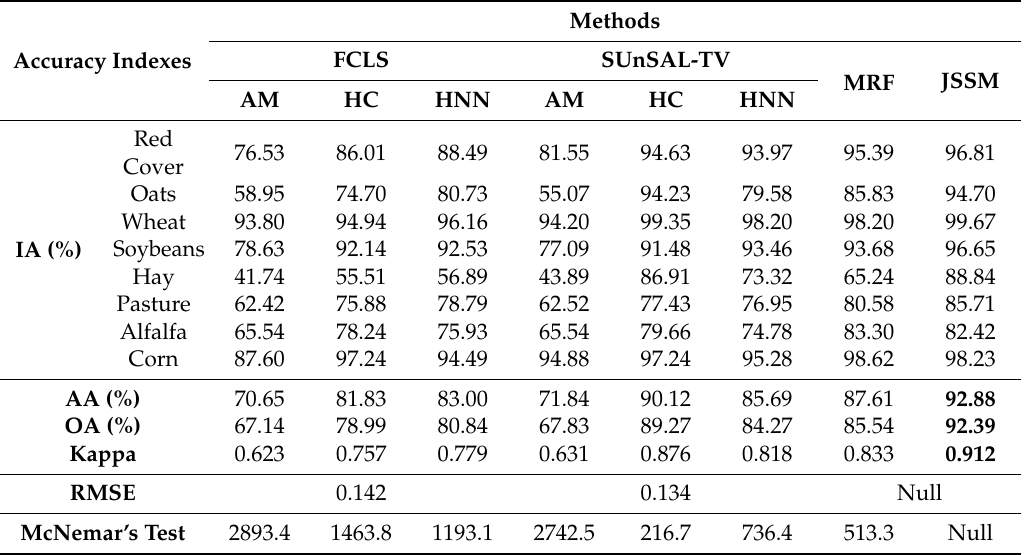
Table 2. Sub-pixel mapping results for the FLC1